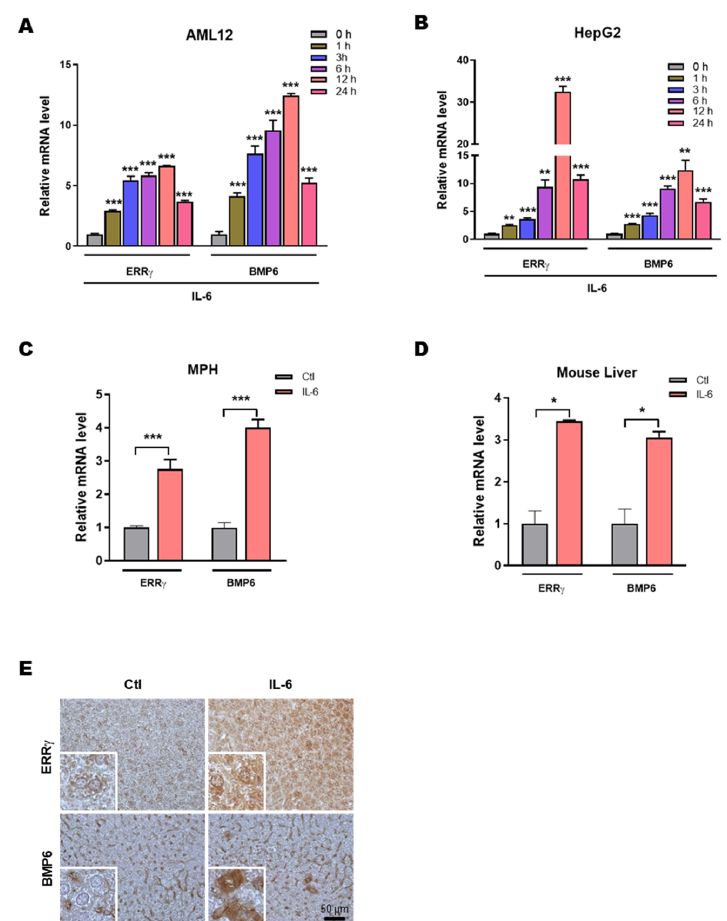
Figure 1. IL-6 promotes hepatic ERRγ and BMP6 gene expression . A and B , cultured AML12 ( A ) and HepG2 ( B ) cells were treated with IL-6 for indicated time period. The cells were then harvested